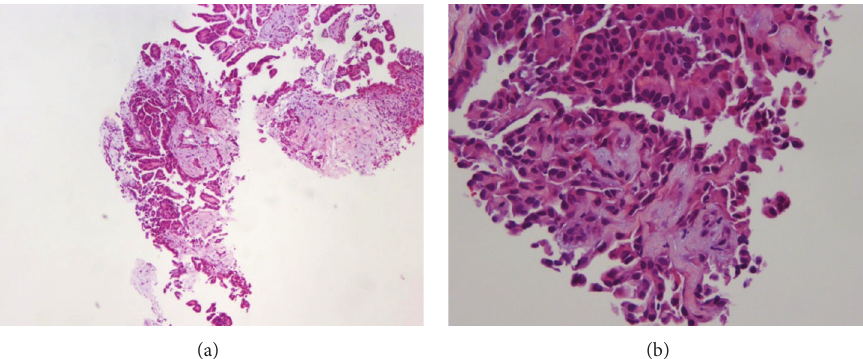
Figure 3: Hematoxylin and eosin (H&E) stain ((a) 5x magnification; (b) 20x magnification) showing a proliferation of abnormal mesothelial cells with moderate cellular atypia present in a papillary configuration.